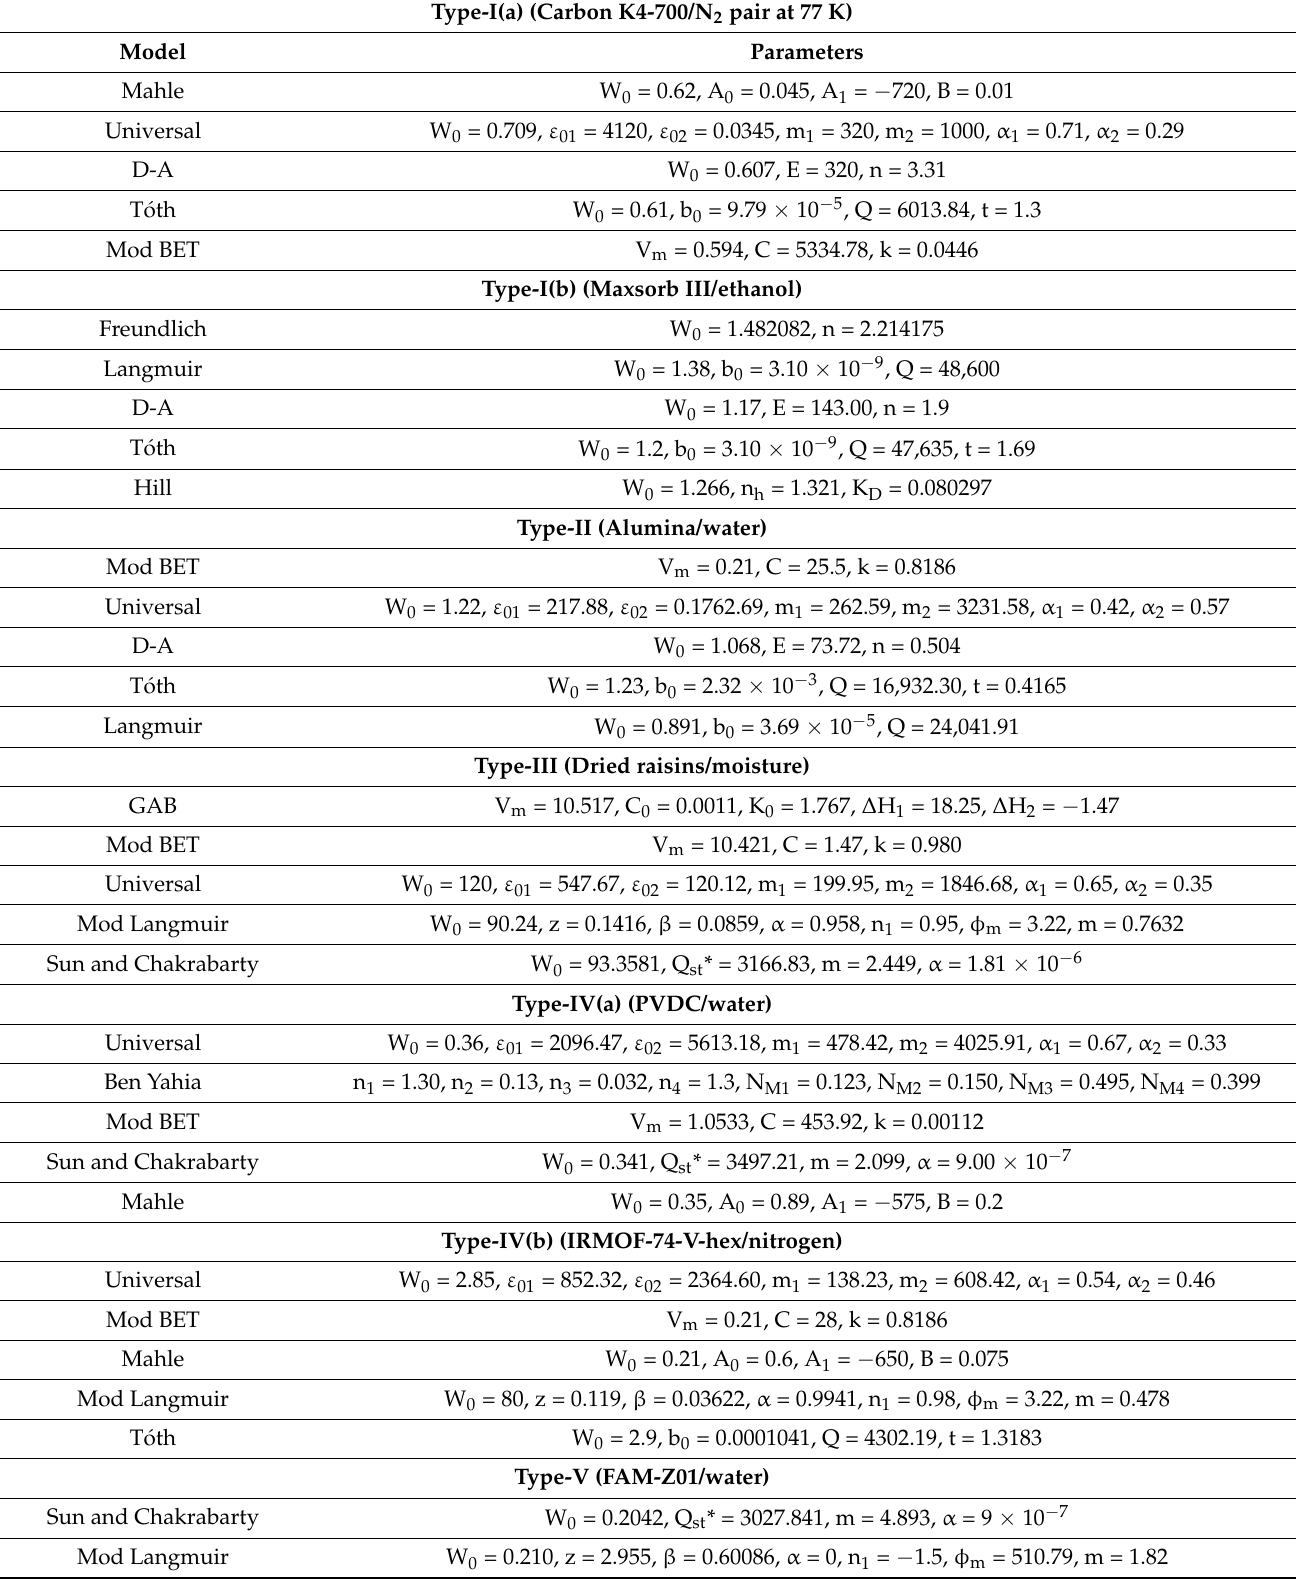
Table 2. Fitting parameters of the candidate models for Type-I(b) adsorption